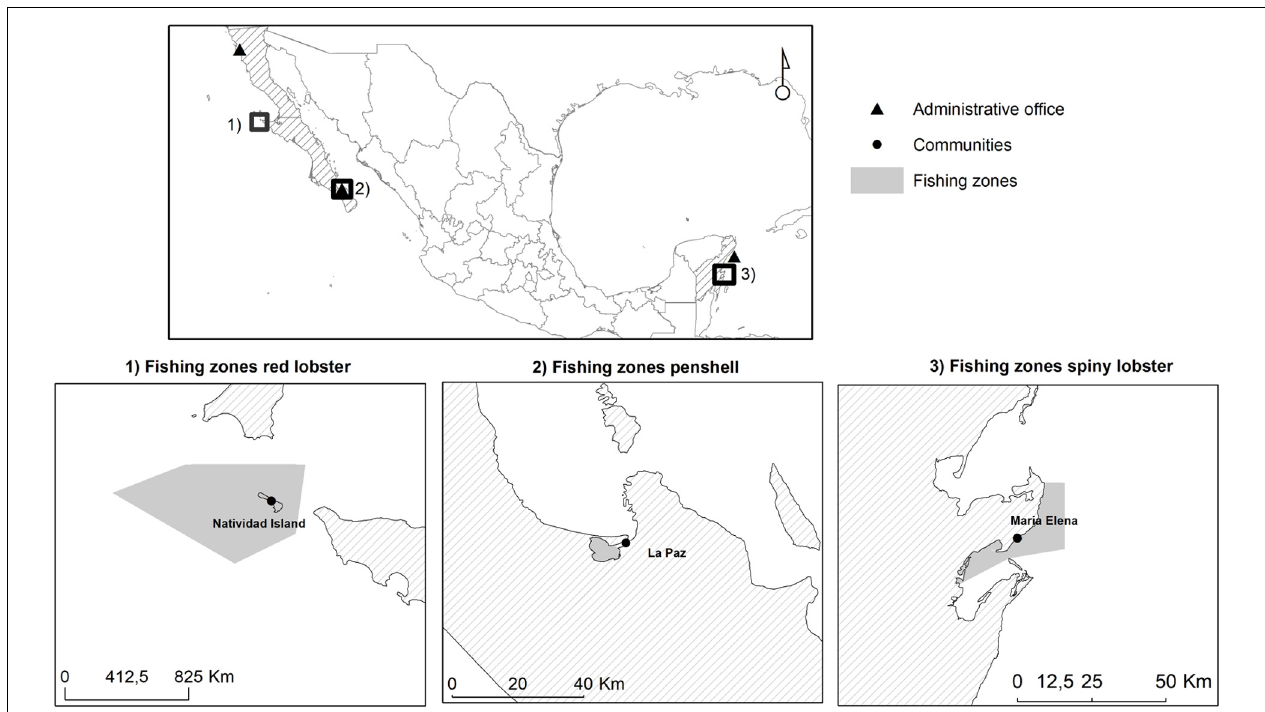
FIGURE 1 | Location of the case studies assessed in this study.